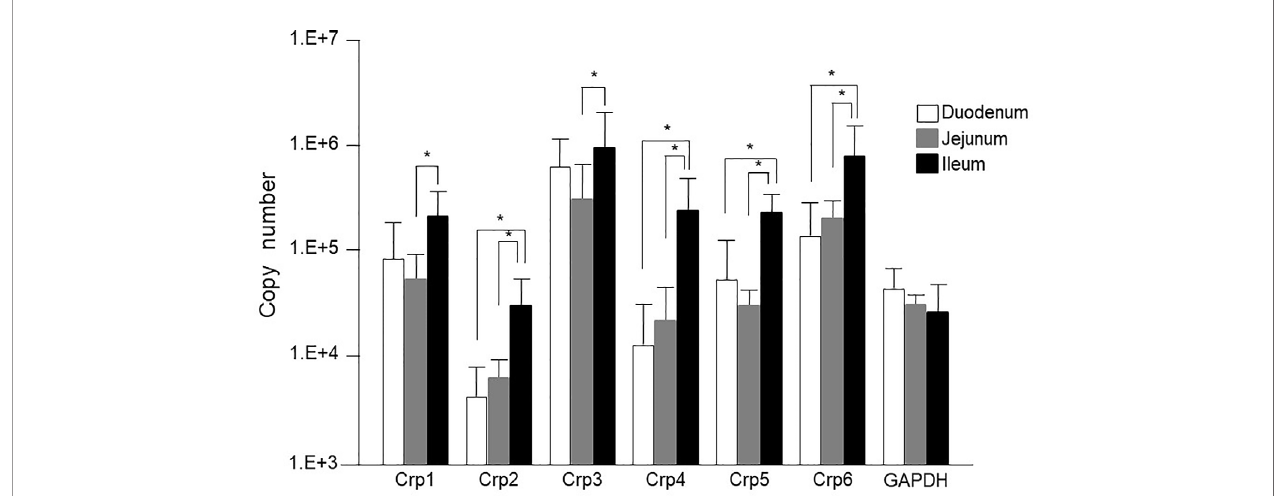
FIGURE 1 | Cryptdin gene expression levels in the isolated single crypt of duodenum, jejunum, and ileum. Crp isoform messenger RNA (mRNA) copy numbers in duodenum, jejunum, and ileum at single-crypt level (n = 10 for each, mean ± SD, *p <